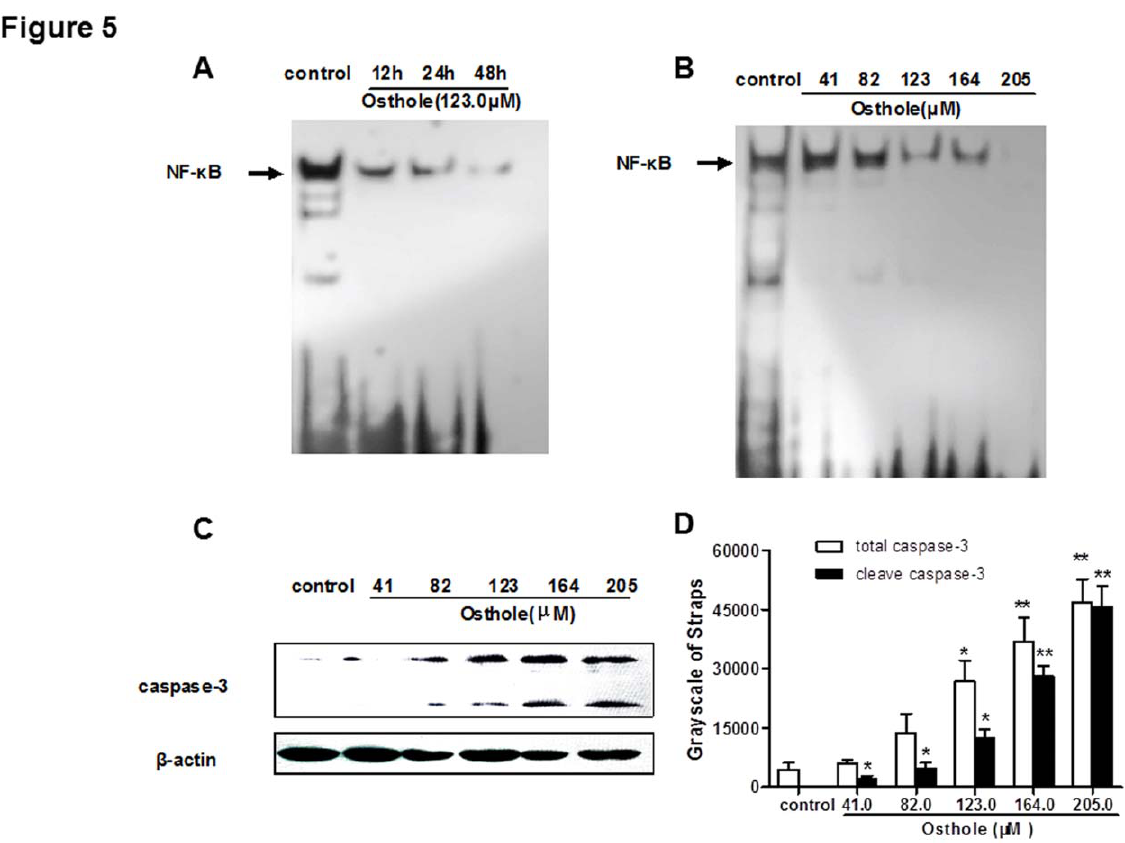
Figure 5. Effects of Osthole Treatment on Caspase-3 expression and NF- k B activation. (A) SMMC-7721 cells were treated with osthole (123.0 m M) for 12 h, 24 h and 48 h. The nuclear proteins were prepared and analyzed for NF- k B expression by EMSA. (B) SMMC-7721 cells were treated with osthole at doses of 0, 41.0, 82.0, 123.0, 164.0 and 205.0 m M for 24 h. The nuclear proteins were prepared and analyzed for NF- k B expression by EMSA. (C) SMMC-7721 cells were treated with osthole at doses of 0, 41.0, 82.0, 123.0, 164.0 and 205.0 m M for 48 h. The cell lysates were prepared and analyzed for caspase-3 expression by Western blot analysis. Equal loading was confirmed by stripping immunoblots and reprobing for b -actin. Data shown were representatives of three experiments. (D) Statistical analysis of caspase-3 quantification. * p , 0.05, ** p ,